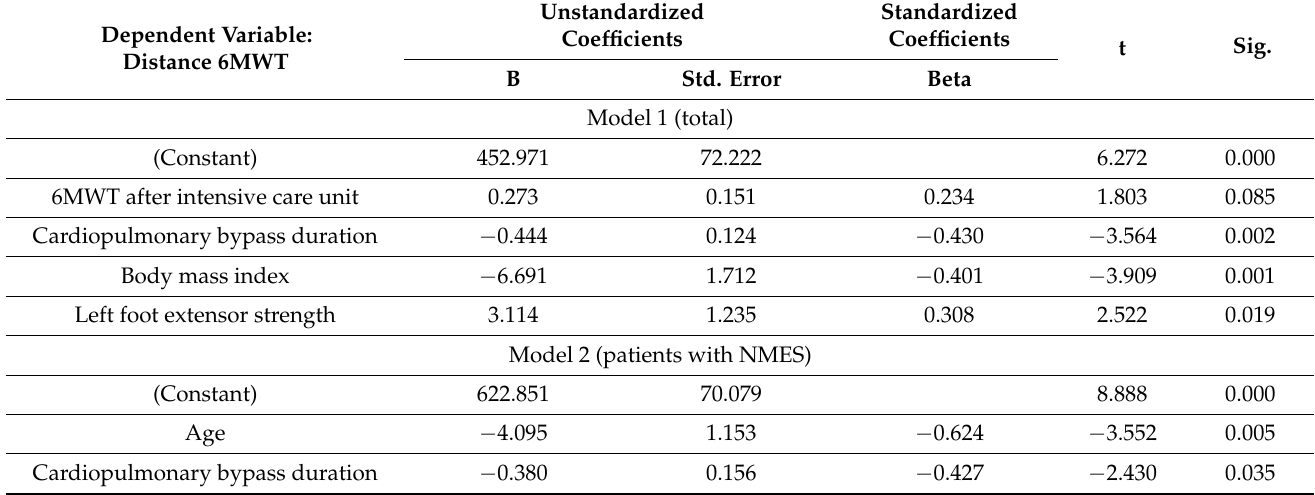
Table 4. Linear regression analysis (stepwise method) for the relationship of distance 6MWT at discharge with other variables ( n =